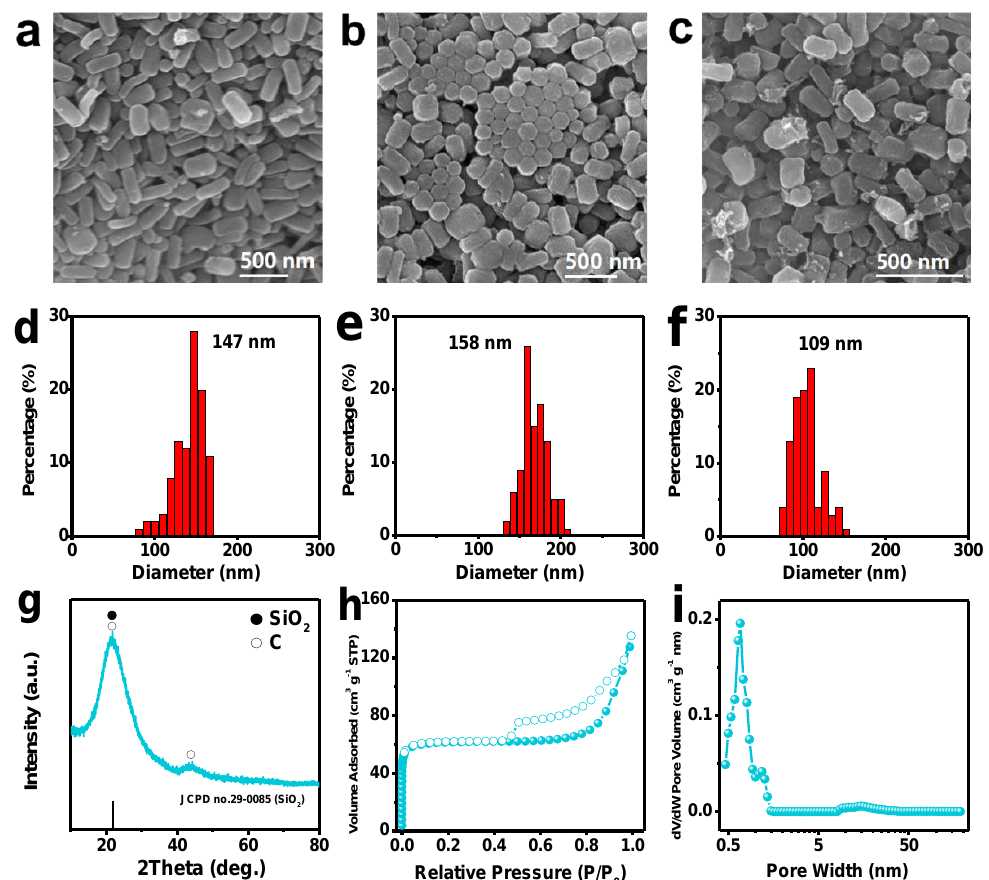
Figure 1. SEM images of ( a ) SiO 2 , ( b ) SiO 2 @PDA-1 complex, and ( c ) SiO 2 @CCNRs-1. Particle size distributions of ( d ) SiO 2 , ( e ) SiO 2 @PDA-1, and ( f ) SiO 2 @CCNRs-1. ( g ) XRD pattern, ( h ) N 2 adsorption-desorption isotherm, and ( i ) pore size distribution curve of SiO 2 @CCNRs-1. The lithium ion storage behavior of SiO 2 @CCNRs as anode material for LIBs is explored.